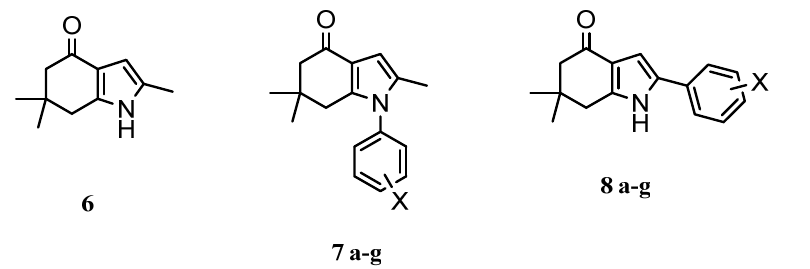
Figure 1. Indol-4-ones 6 , 7a – g and 8a – g (X: a = H, b = 2-F, c = 4-F, d = 2,4-diF, e = 2-Cl, f = 4-Cl, g = 2,4-diCl). We used the original numbering of the compounds that were synthesized in [22].